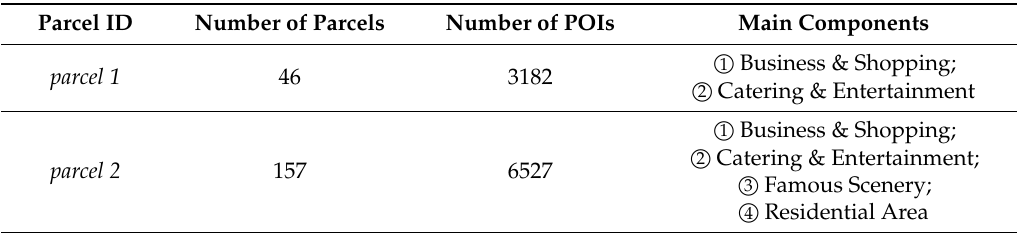
Table 2. Description of test data.